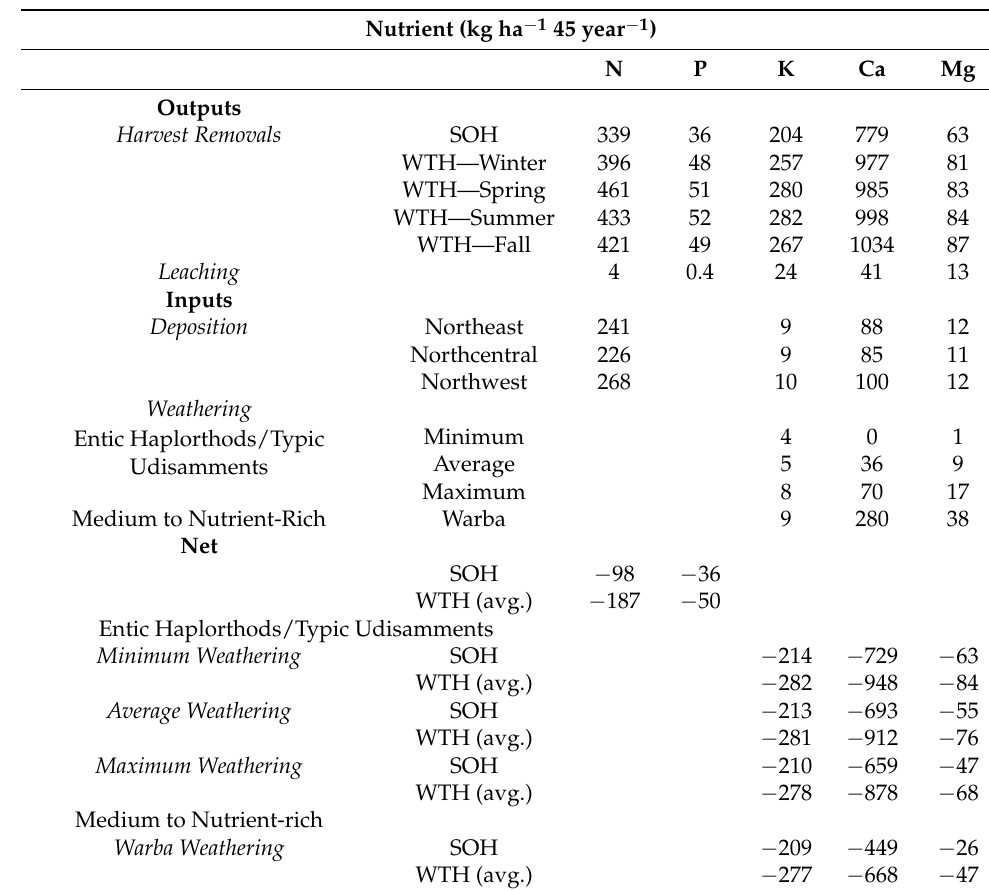
Table 2. Harvest simulations macronutrient inputs and outputs of a single rotation, as well as weathering rates and deposition by